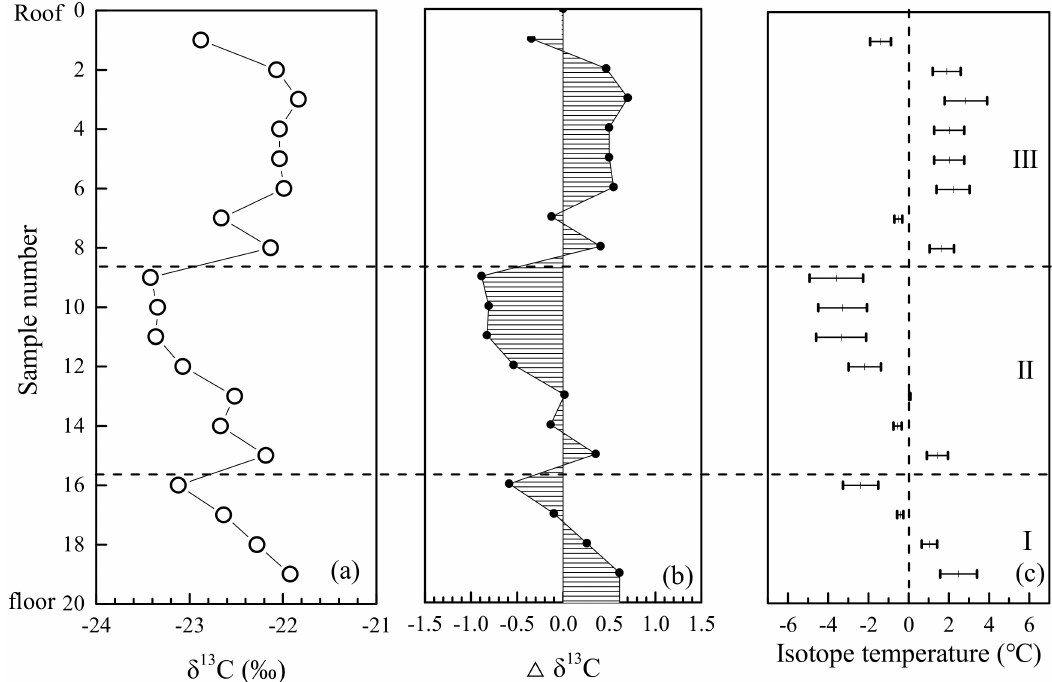
Figure 17. ( a ) Vertical carbon isotope record of lignite ( o / oo vs. PDB); ( b ) normalized record (line) ∆ δ 13 C given as δ 13 C minus the average value of the entire coal seam; and ( c ) +0.39 o / oo13 C/ ◦ C was adopted in the lowest temperature change calculation obtained by [108] and +0.18 o / oo13 C/ ◦ C used in highest temperature changes found by